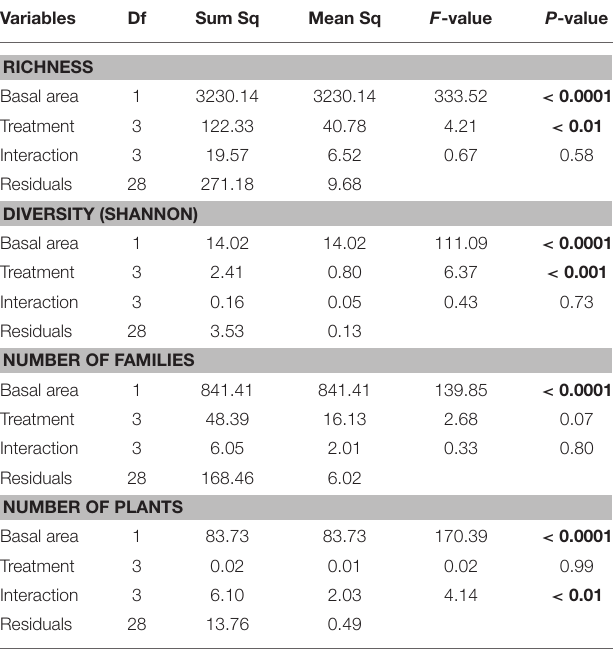
TABLE 3 | Analysis of covariance relating plant richness, diversity (Shannon index), number of families and number of individual plants with basal area and treatments (regime of